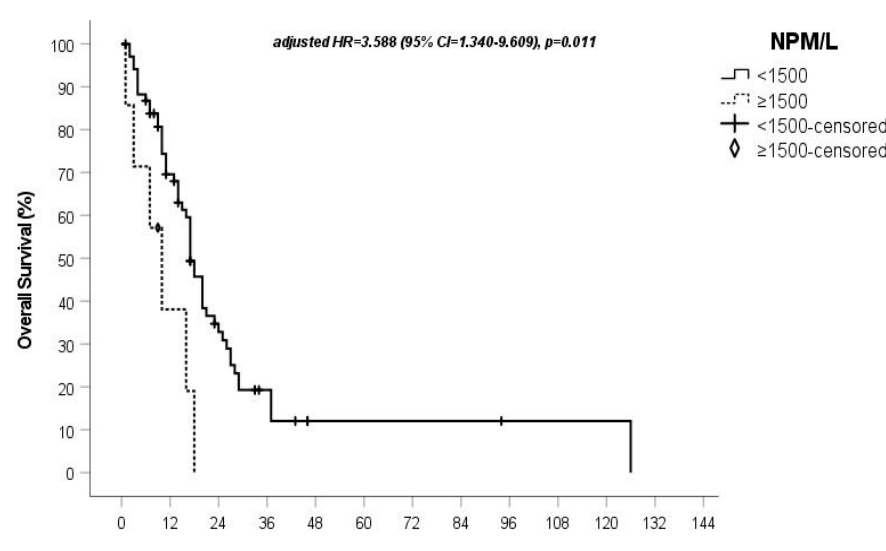
Time from the start of radiotherapy (months) Figure 2. Survival outcomes, based on NPM/L value Figure 2. Survival outcomes, based on NPM/L value stratification.